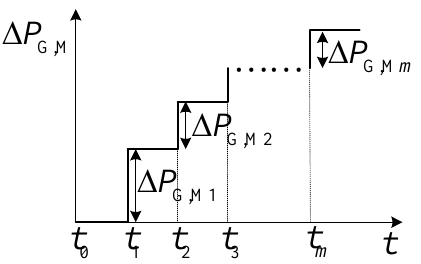
Figure 1. First-order model of governor delay.